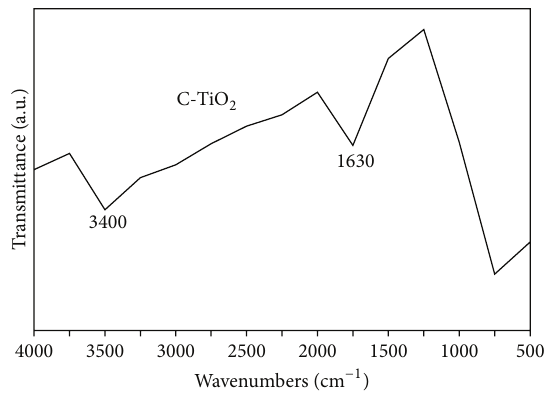
Figure 4: The FTIR spectra of C-TiO 2